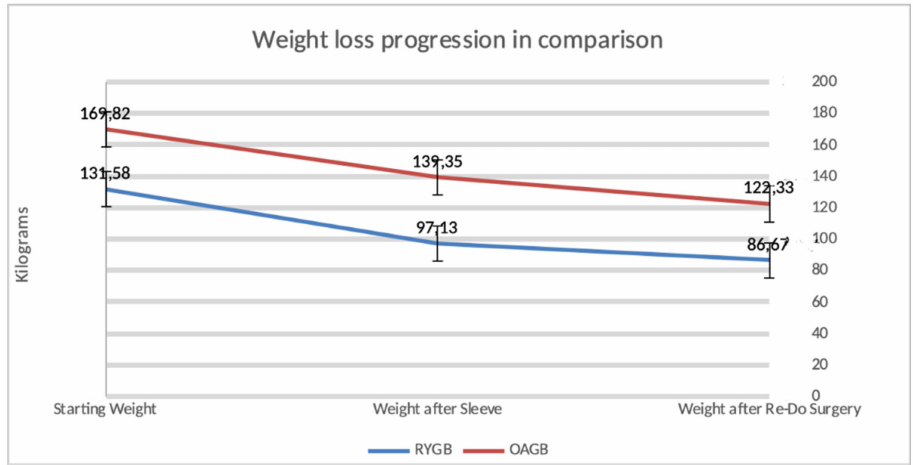
Figure 2. Progression of weight loss occurring in our study population after a secondary bariatric procedure.